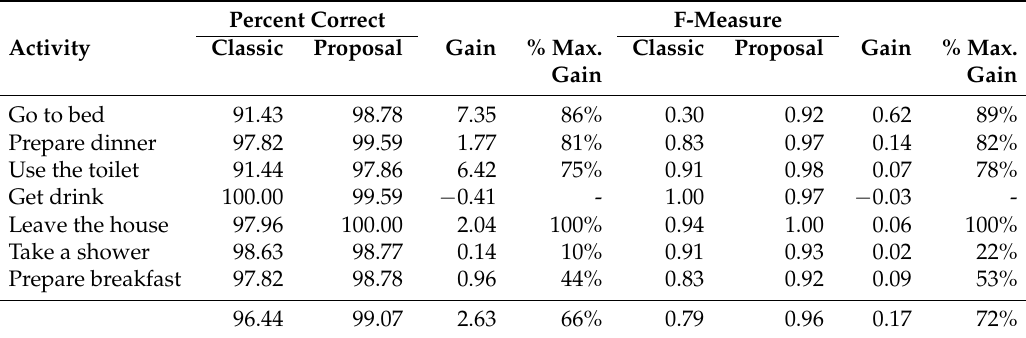
Table 11. Global classification